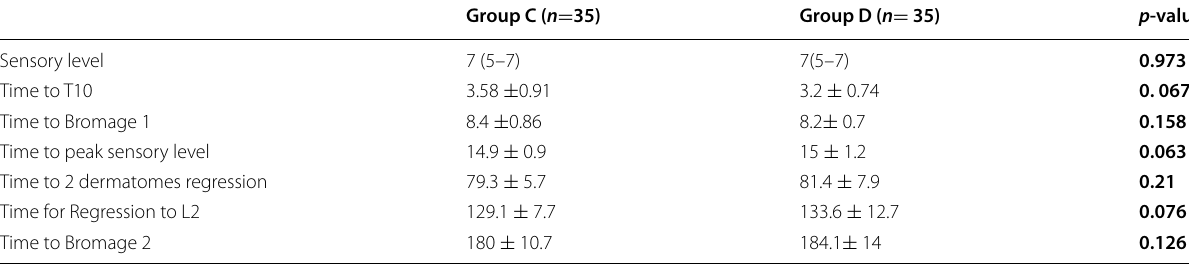
Data are presented as mean SD, median (IQR) ± P value < 0.05 is considered statistically significant P value > 0.05 is considered statistically non-significant